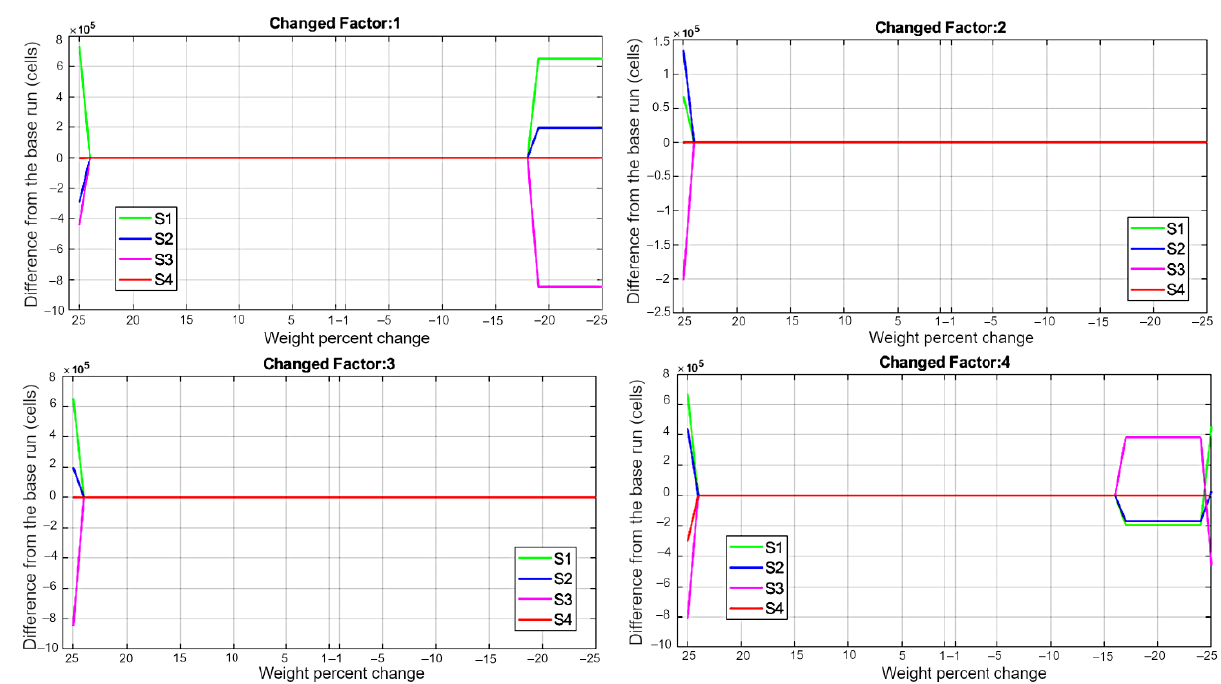
Figure 4. Soil retention capability: Cell differences compared to the base model. Summary results from 200 simulations (50 runs for each criterion). Factor 1: soil pH, factor 2: ferrallitisation, factor 3: organic matter, factor 4: soil texture. S1: no capability for Al 3+ retention in the soil, S2: little capability, S3: moderate capability, and S4: strong capability.